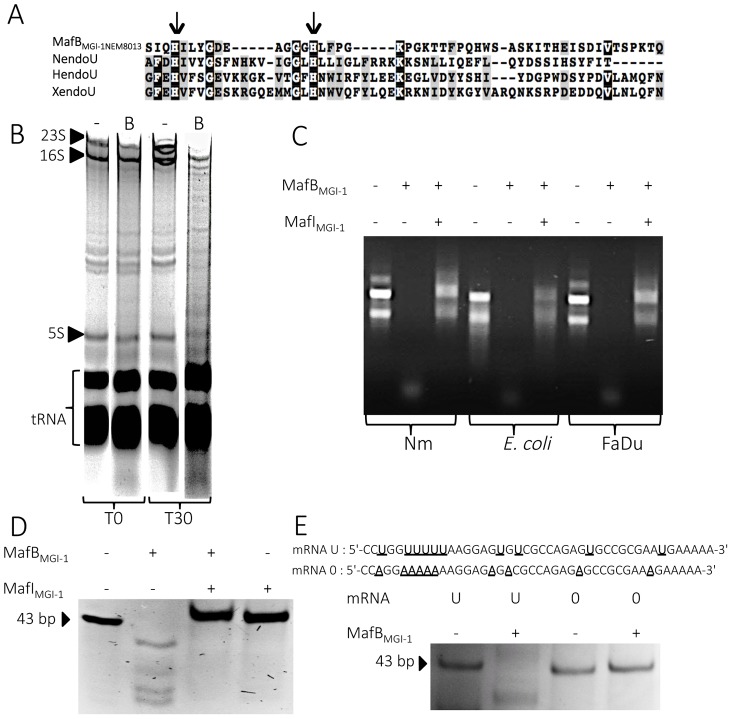
MafBMGI-1NEM8013 is a bacterial EndoU nuclease.A) Partial sequence alignment of EndoU nuclease domain of Nidovirus Nsp15 protein (NendoU; NP_740619), Xenopus laevis XendoU (Q8JFY9), human placental protein PP11 (HendoU P21128) and MafBMGI-1 from NEM8013 strain (C9X2Z7). The arrows indicate two conserved histidine residues, which are part of the catalytic site of previously characterized EndoU nucleases. Multiple alignment was performed using MUSCLE and shaded using the BoxShade server. Residues that are identical or similar in at least three of the four sequences are shaded with black or grey background respectively. B) Analysis of in vivo impact of MafBMGI-1NEM8013 expression in E. coli. Total RNA from E. coli expressing MafBMGI-1NEM8013 (pBAD33-mafBMGI-1NEM8013) was isolated before induction (T0) and 30 min after addition of L-arabinose (T30). Samples were run on 5% denaturing polyacrylamide gels and stained with ethidium bromide. Positions of 23S, 16S, and 5S rRNAs and tRNAs are shown. -, empty vector control; B, E. coli expressing MafBMGI-1NEM8013 from pBAD33 C) RNase activity of purified recombinant MafBMGI-1NEM8013 was assessed by incubating MafBMGI-1NEM8013 -His6 alone or with MafIMGI-1NEM8013 -His6 with total RNA isolated from different sources (N. meningitidis NEM8013, E. coli TOP10 and human epithelial cells FaDu). Each reaction was performed for 30 min at 37°C with 4 µg of RNA in Tris-EDTA buffer. D) Synthetic mRNA of 43 bp was incubated with purified MafBMGI-1NEM8013-His6 alone or with MafIMGI-1NEM8013 -His6 in Tris-EDTA buffer for 15 min at 37°C. The cleavage products were separated by electrophoresis in a 14% polyacrylamide/8M urea gel and were visualized by ethidium bromide staining. E) Synthetic oligoribonucleotides containing several uridylates (U) or none (0) were incubated with purified MafBMGI-1NEM8013-His6 in Tris-EDTA buffer for 20 min at 37°C. The reaction products were analyzed by 14% polyacrylamide/8 M urea gel. Sequences of synthetic oligonucleotides used in this experiment are shown.